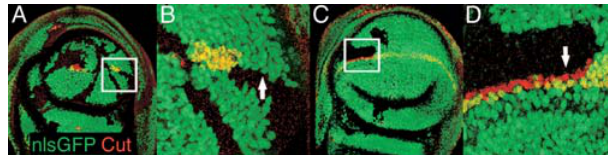
Large dorsal clones of D-mib 2 mutant cells (marked by the loss of nuclear GFP, in green) resulted in a complete loss of Cut (red) expression (A and B). This indicates that D-mib is required for Ser signaling by dorsal cells. In contrast, ventral clones did not prevent the expression of Cut (C and D), implying that D-mib is not strictly required for Dl signaling. Note that mutant ventral cells abutting wild- type dorsal cells expressed Cut (arrow in [D]), indicating that D-mib is notrequiredfor N signaltransduction.Low-magnification viewsof the wing portion of the discs are shown in (A) and (C). (B) and (D) show high-magnificationviewsoftheareasboxedin(A)and(C),respectively. DOI: 10.1371/journal.pbio.0030096.g006